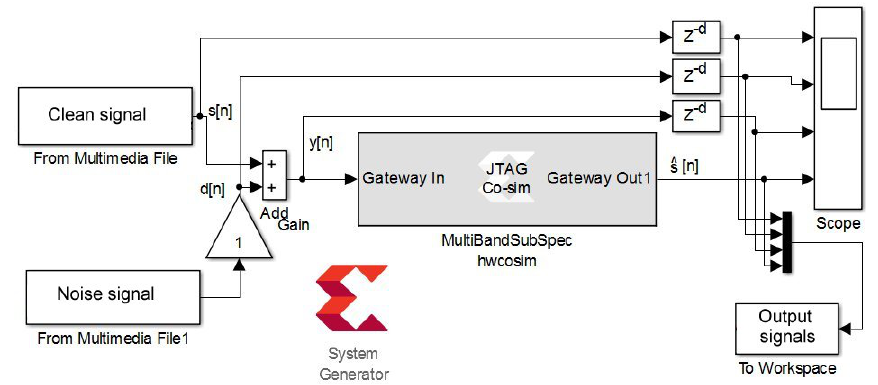
Figure 3. Hardware co-simulation corresponding to the diagram of Figure 2, where s [ n ] is clean speech signal, d [ n ] is the noise, y [ n ] is the corrupted speech signal, and (cid:98) s [ n ] is the enhanced speech. JTAG: Joint Test Action Group